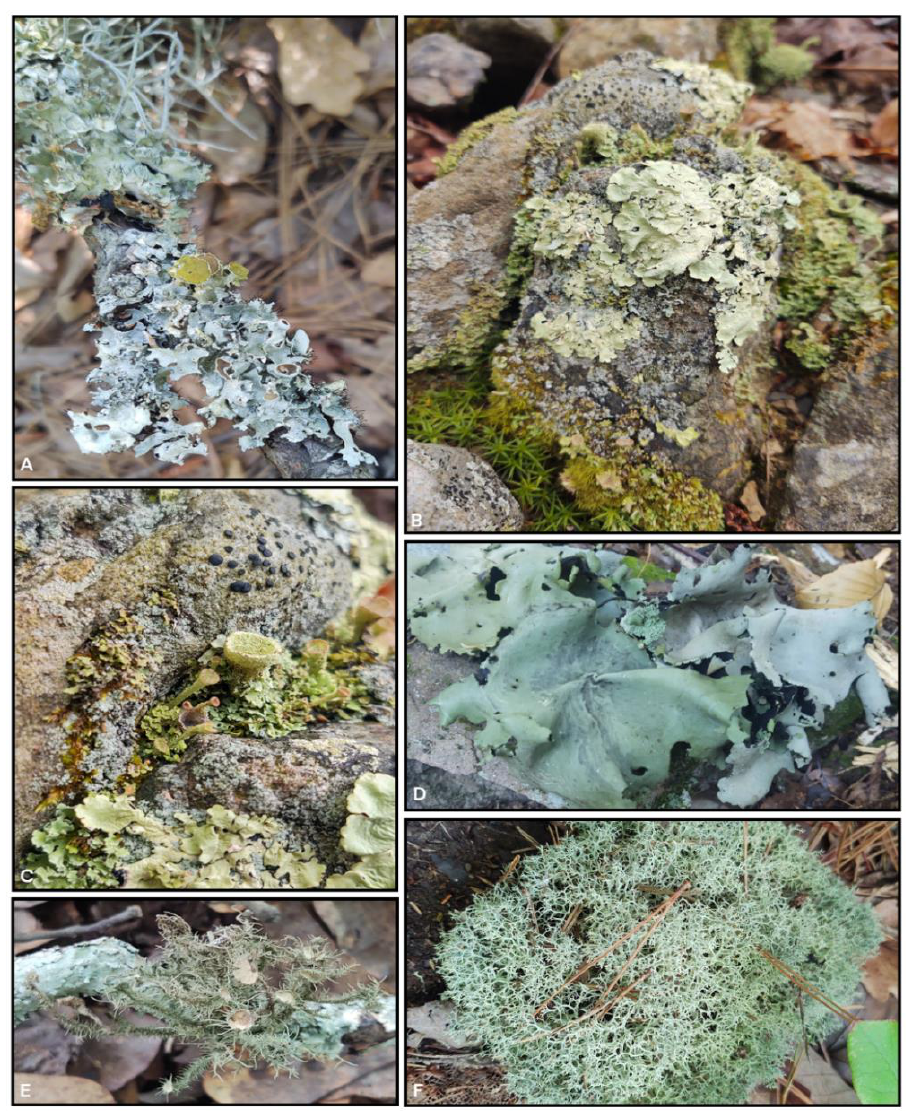
Figure 1. Examples of lichen species sampled in this study. ( A ) Parmotrema sp.; ( B ) Xanthoparmelia sp.; ( C ) Cladonia sp.; ( D ) Umbilicaria sp.; ( E ) Usnea sp.; ( F ) Cladonia sp.